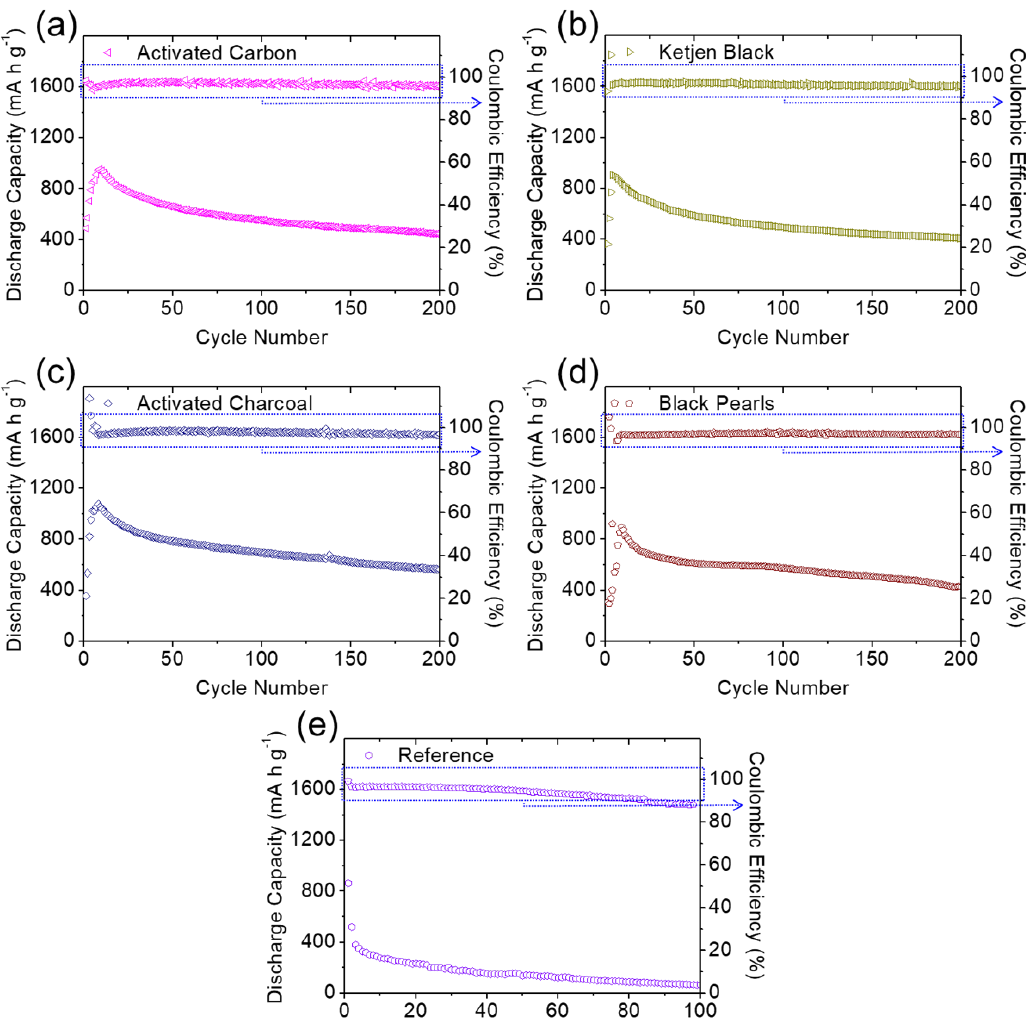
Figure 6. Electrochemical analysis: long-term cyclability of the high-loading sulfur cathode in the lean-electrolyte cells with different carbon coating modules of ( a ) activated carbon, ( b ) Ketjen black, ( c ) activated charcoal, ( d ) Black Pearls, and ( e ) an uncoated reference cell.